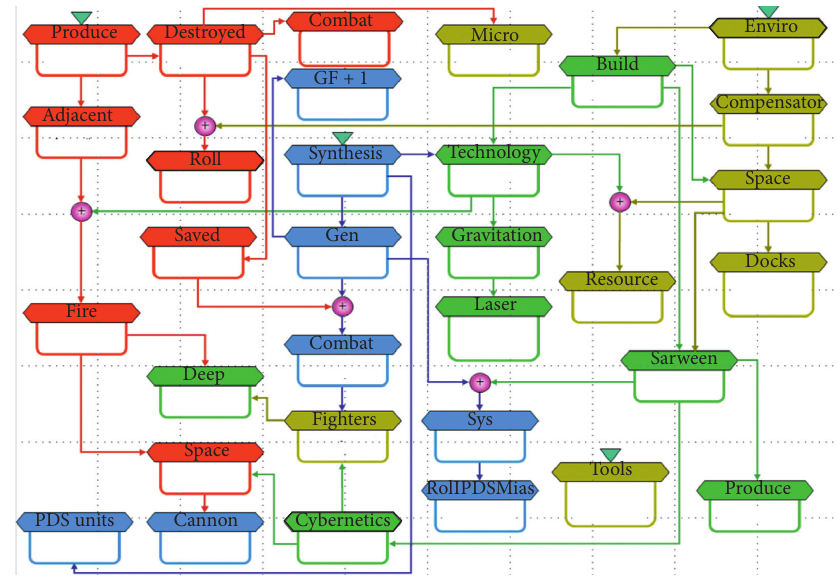
Figure 1: Model of improved decision tree